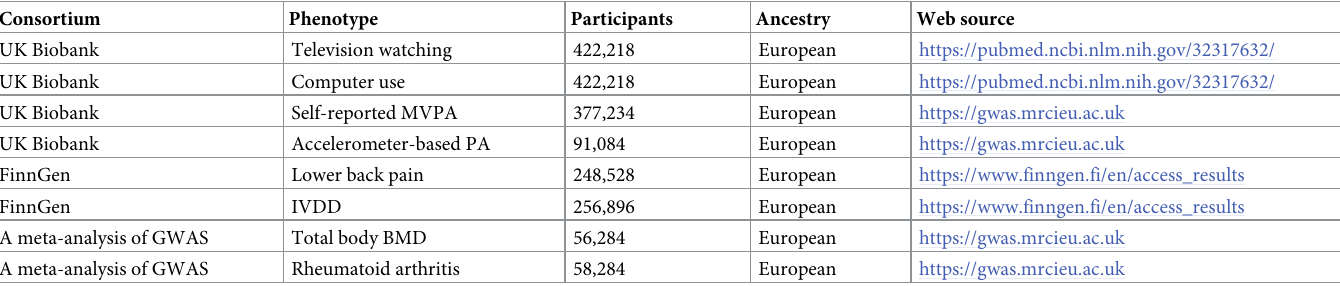
Table 1. Details of the GWASs included in the Mendelian